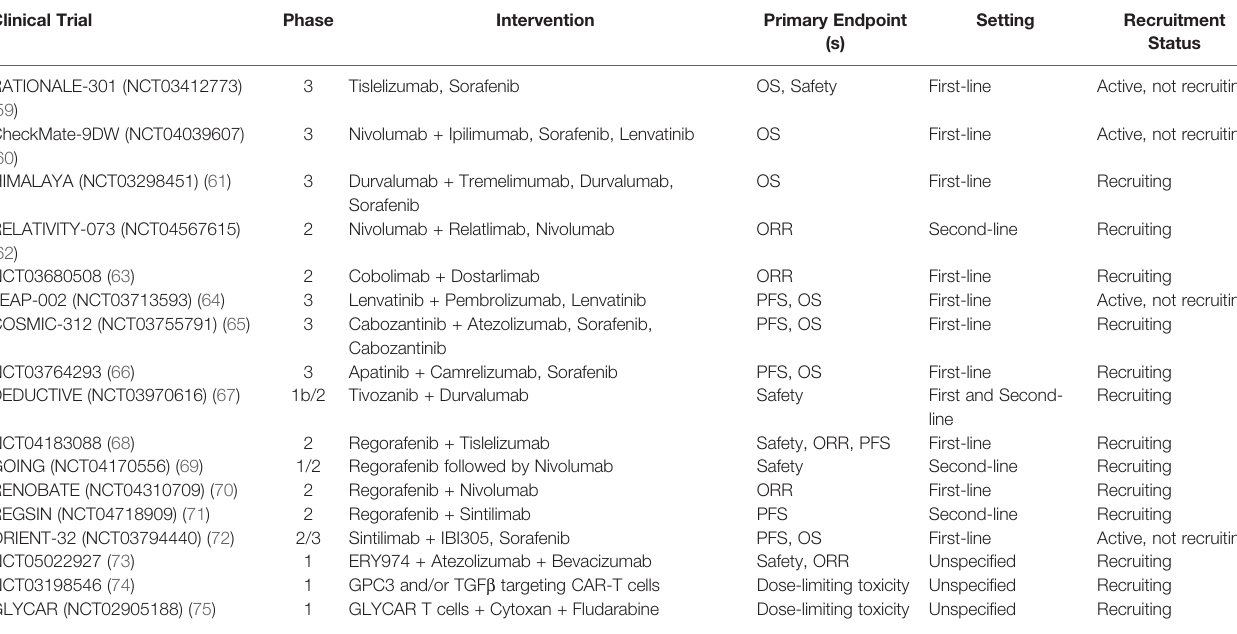
TABLE 2 | Select ongoing clinical trials on immunotherapy in advanced